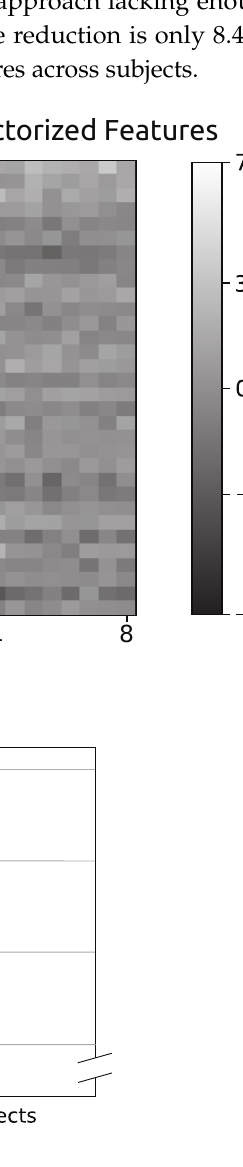
Figure 6. Hand-gesture classification accuracy for different test